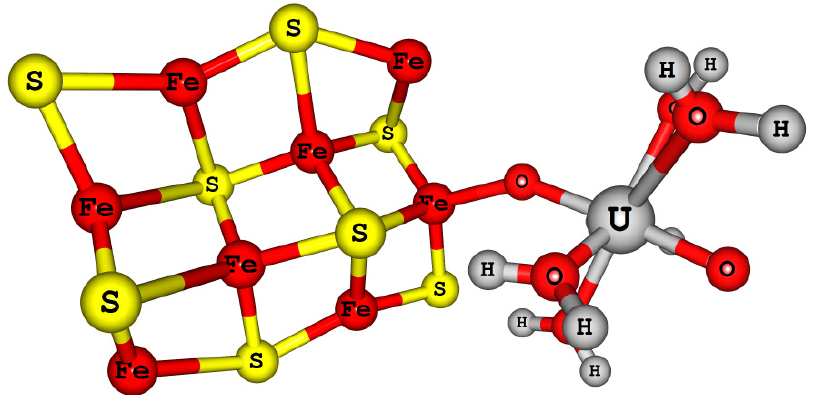
S -UO (H O) ] 2+ ) model. 8 8 2 2 5